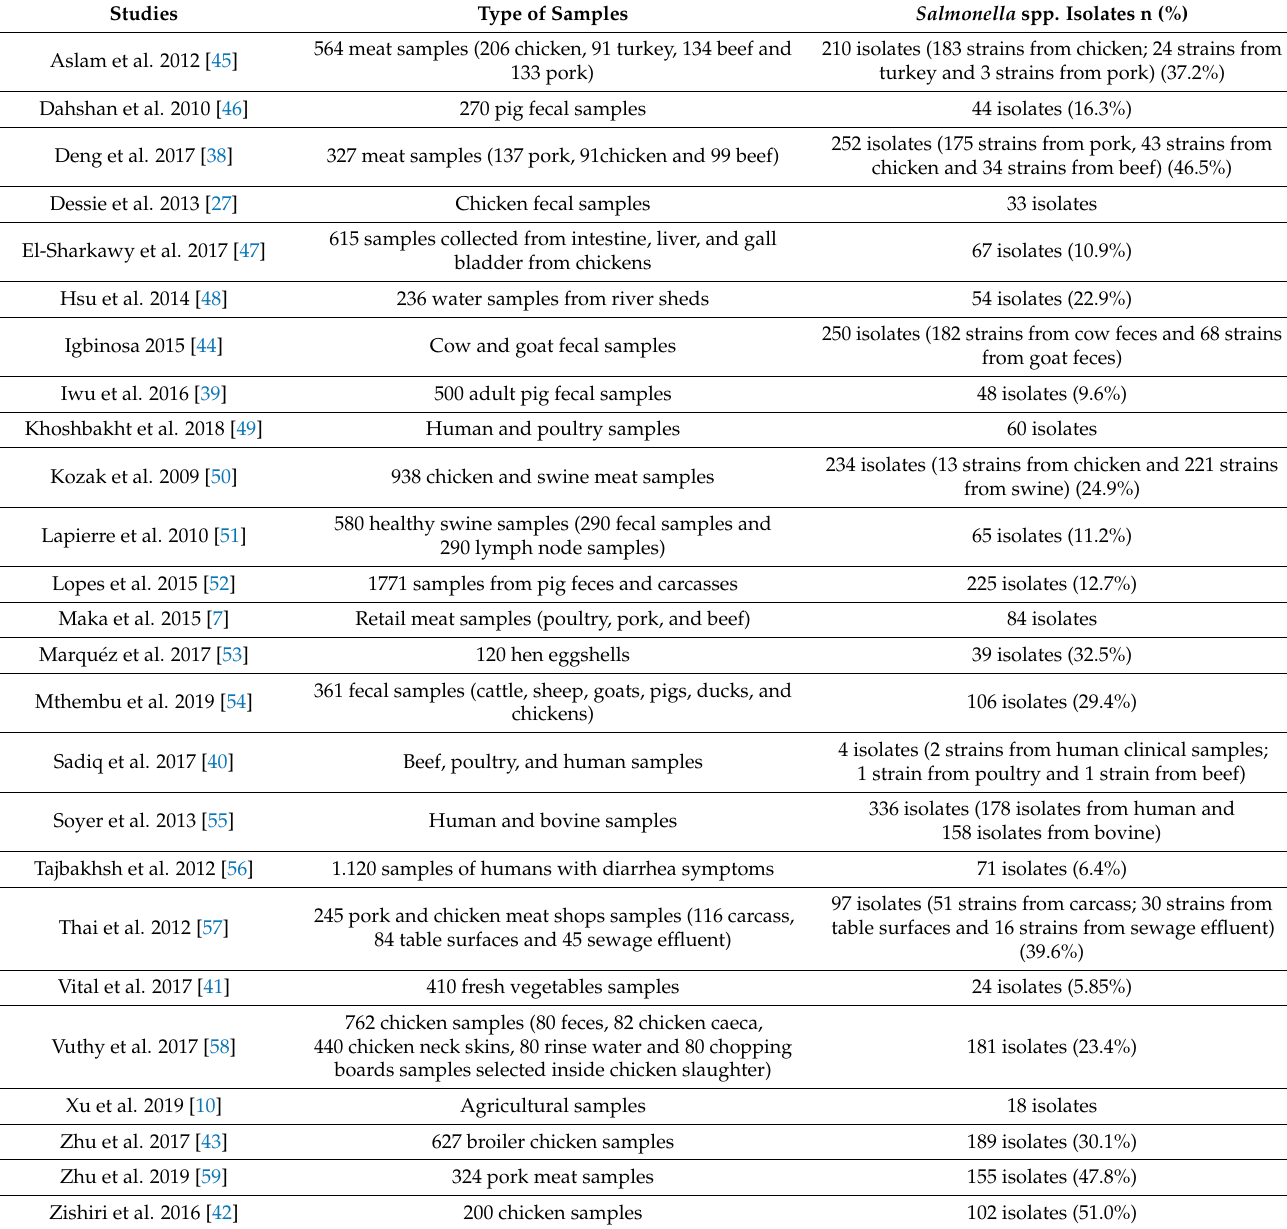
Table 5. Type of samples used to isolate Salmonella